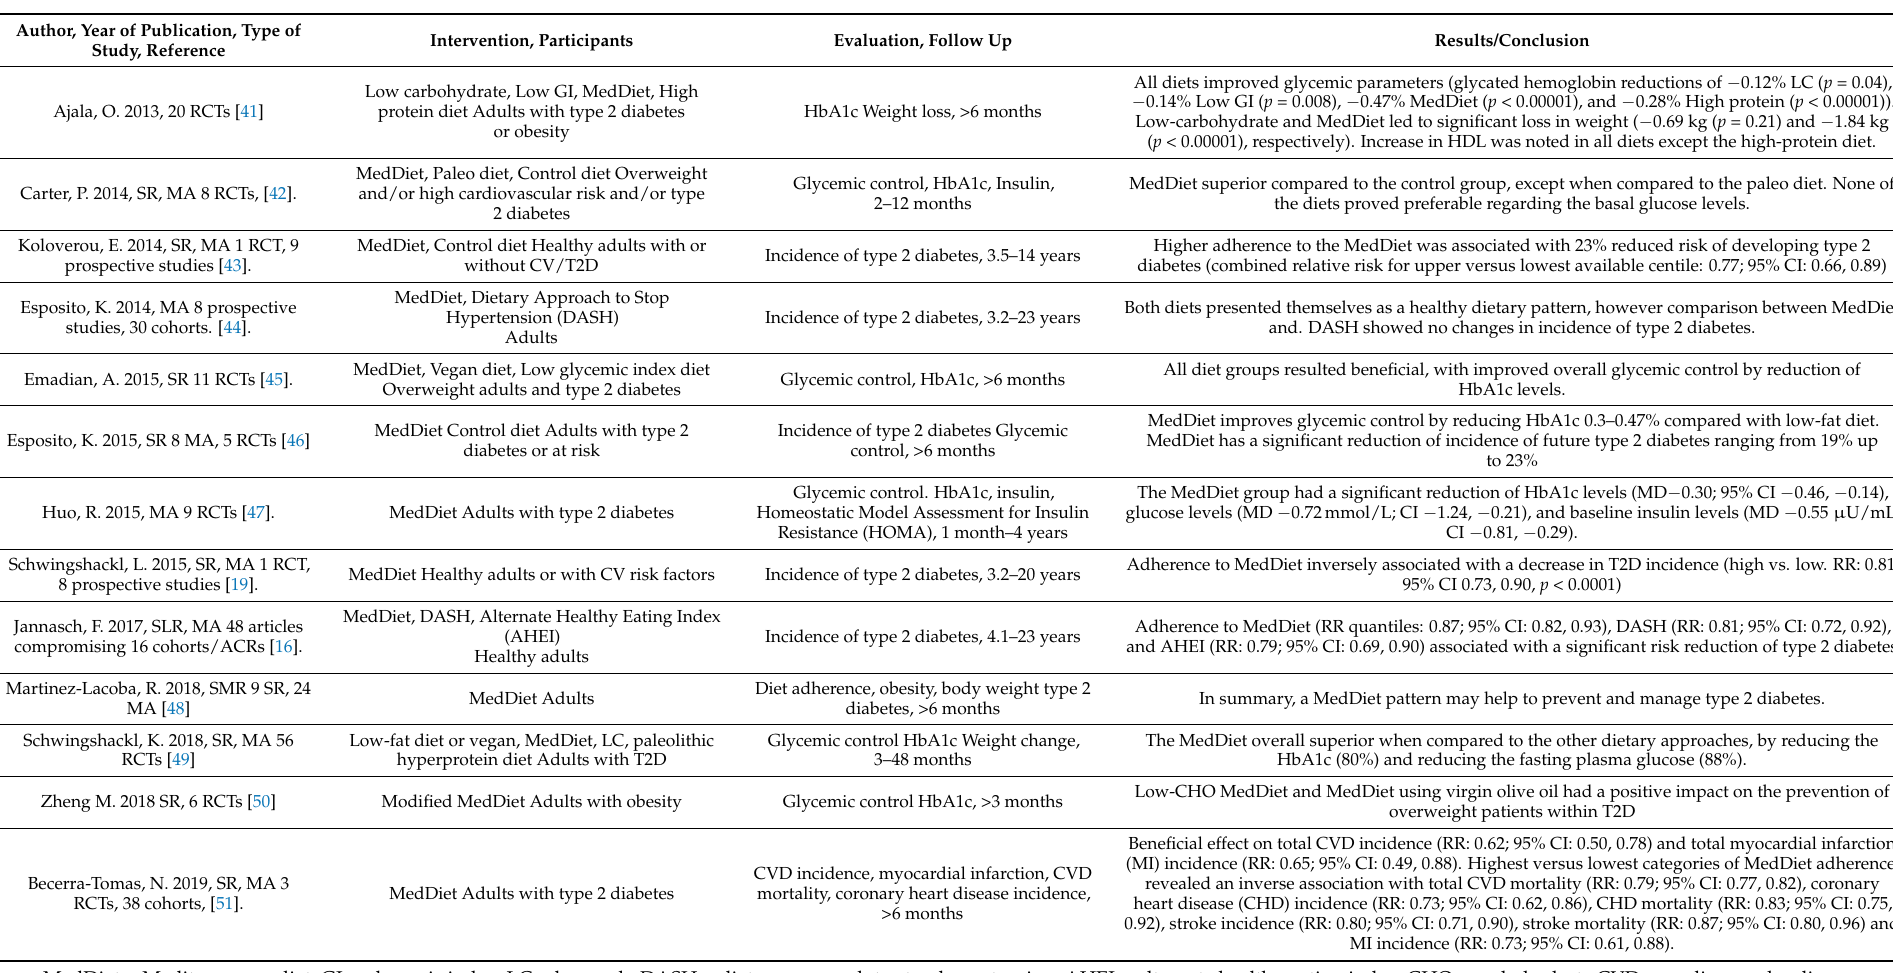
Table 1. Systematic reviews and meta-analysis of the association between the Mediterranean diet and type 2 diabetes (T2D)